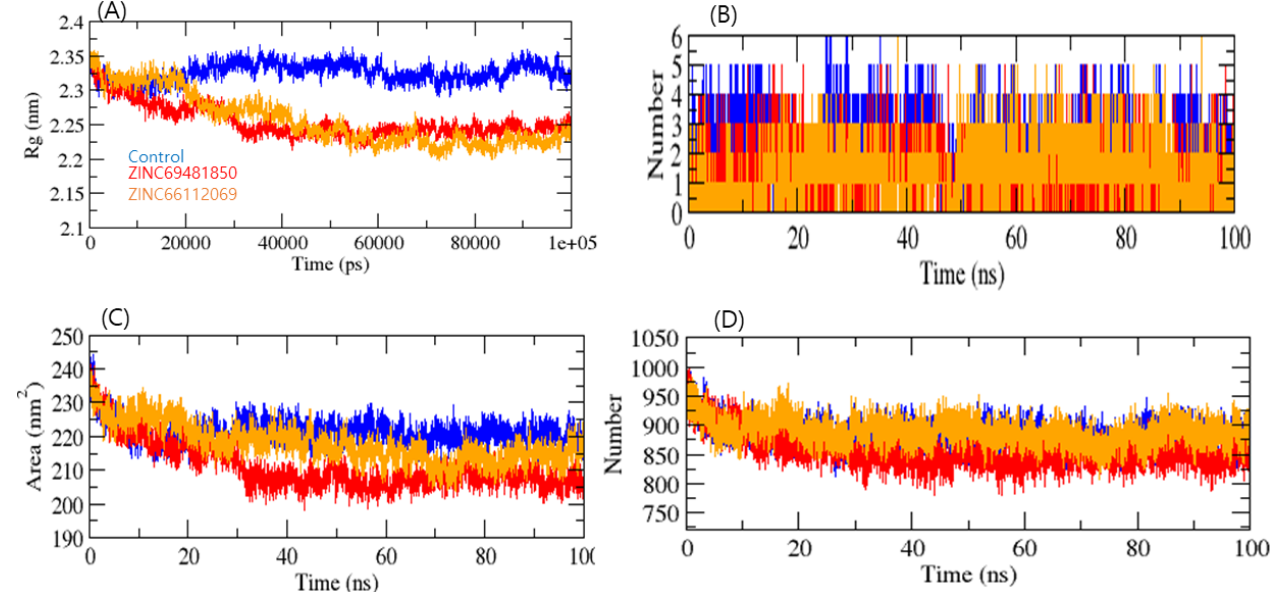
Figure 6. Radius of gyration of complexes ( A ), Number of H-Bonds in complexes ( B ), SASA plot ( C ), and Number of H-Bonds between RdRp and water molecules ( D ). PPNDS, ZINC69481850, and ZINC66112069 were shown in blue, red, and orange colors, respectively.